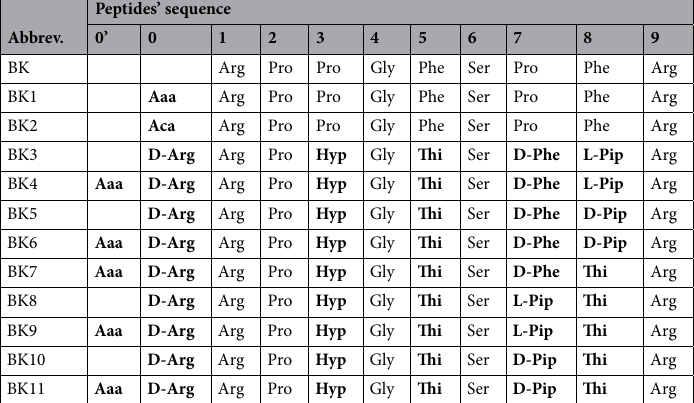
Table 1. Sequences of studied bradykinin analogs. Aaa—[(3 s,5 s,7 s)-adamantan-1-yl]acetic acid, Aca -(3 s,5 s,7 s)-adamantane-1-carboxylic acid, Thi – thienylalanine, Pip—piperidine-2-carboxylic acid,